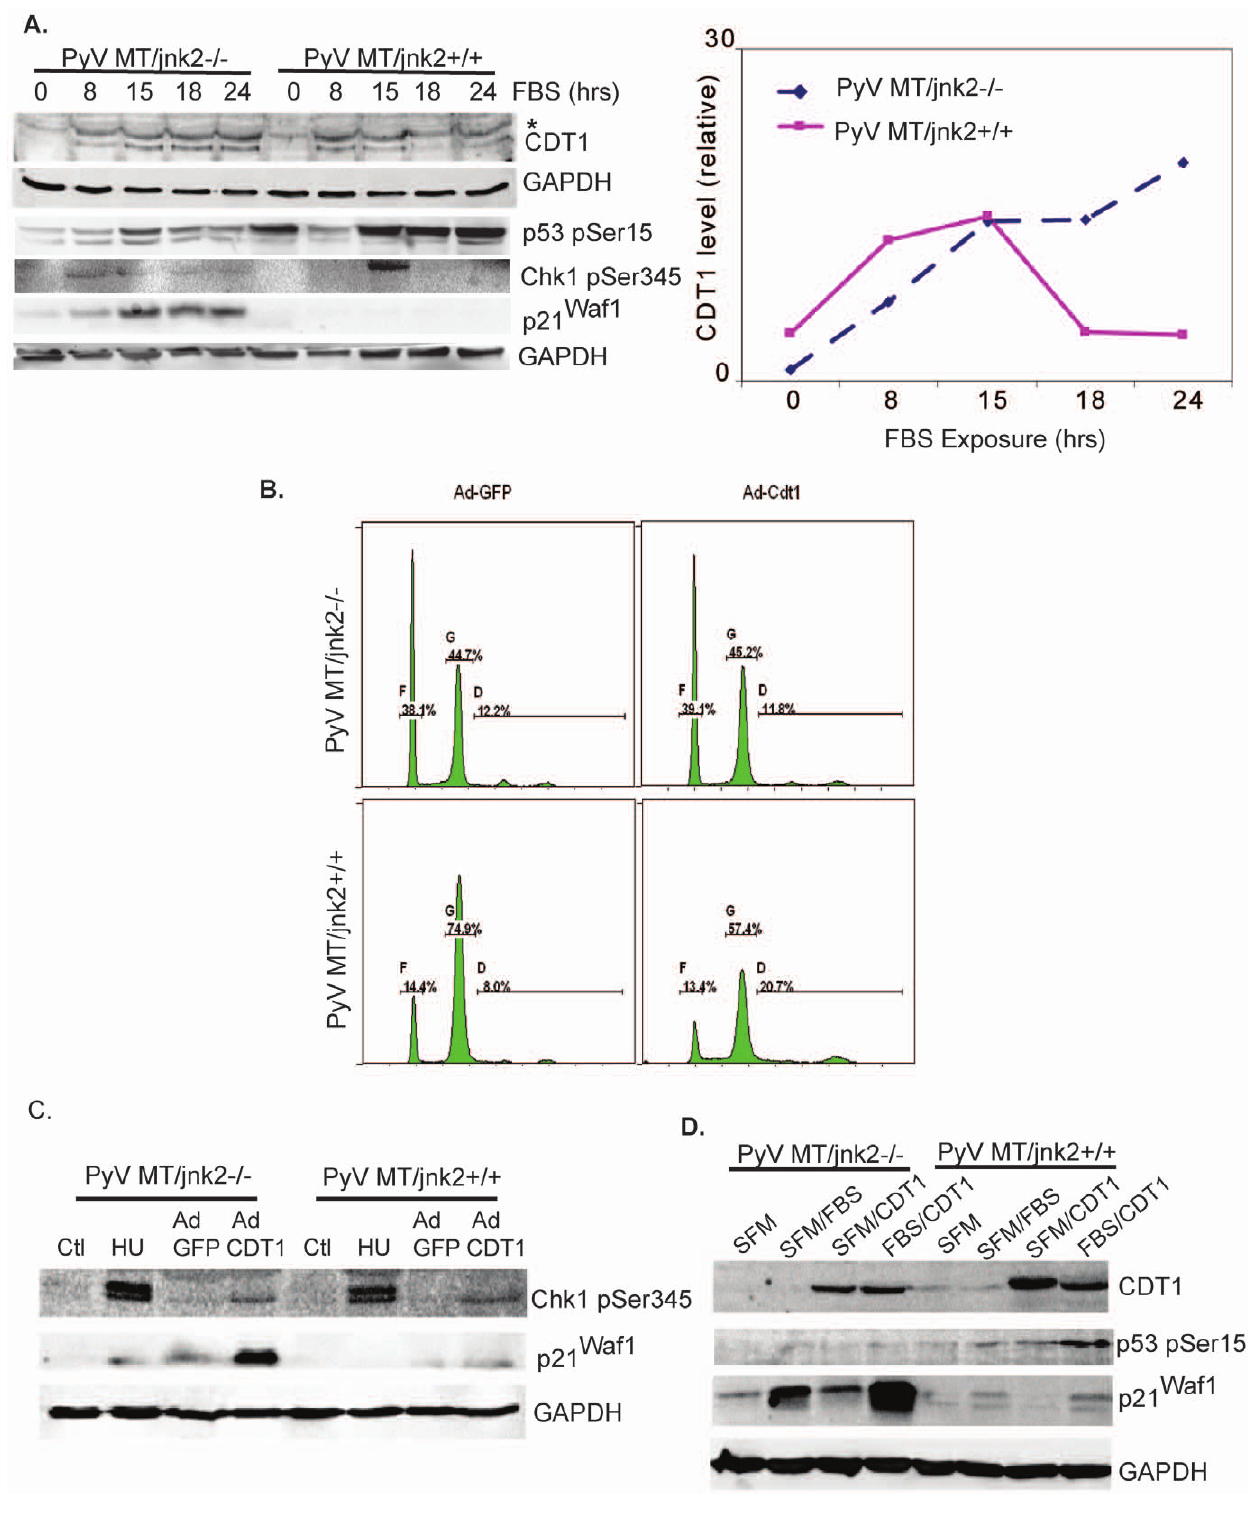
Figure 7. PyV MT/ jnk2 2 / 2 cells experience replicative stress and increased p21 Waf1 expression. A ). Cells were serum starved and then harvested at different time points after 10% FBS stimulation to evaluate CDT1, p21 Waf1 , p-Chk1 (Ser345), and p-p53 (Ser 15) expression by western blot analysis using primary antibodies directed towards the indicated proteins. CDT1 expression at each time point was normalized to GAPDH and graphed for PyVMT/ jnk2 + / + and PyVMT/ jnk2 2 / 2 cell lines; B ). PyVMT/ jnk2 + / + and PyVMT/ jnk2 2 / 2 cell lines were infected with either adenoviral-GFP or adenoviral-CDT1. Forty-eight hours later, cells were stained using PI with RNase, and then evaluated for cell cycle distribution using flow cytometry; C ). Cells were infected with either adenoviral-GFP or adenoviral-CDT1 and harvested 24 hours later. Alternatively, cells were treated with hydroxyurea (HU 5 mM) for 24 hours and then harvested. Western blot analysis was used to measure pChk1 (Ser 345) and p21 Waf1 expression.